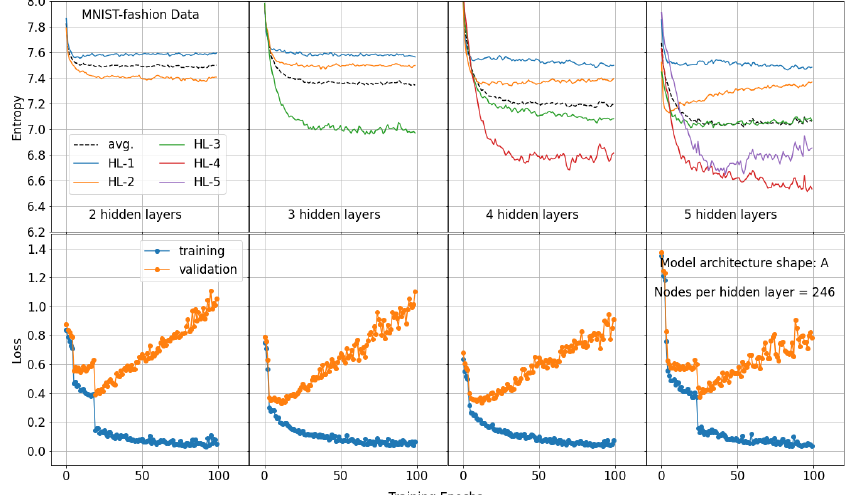
Figure A2. First row of figures show the entropy profile of four different shallow neural networks. Second row shows the corresponding training and validation losses. These models were trained using 60,000 MNIST-fashion images with 33% validation split. NLLLoss [41] was used as the loss function and the Adam optimizer [42] with learning rate 0.001 was used for the model